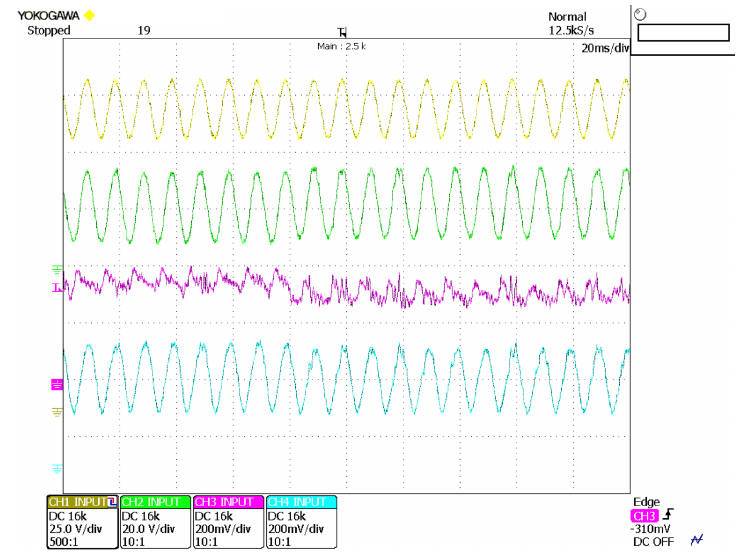
Figure 14. Experimental results of the closed-loop system (20 ms/ div ). CH1 (yellow): V DClink (25 V/ div ). CH2 (green): V Cs , (20 V/ div ). CH3 (magenta): I LEDs (200 mA/ div ). CH4 (blue): I Lsto (200 mA/ div